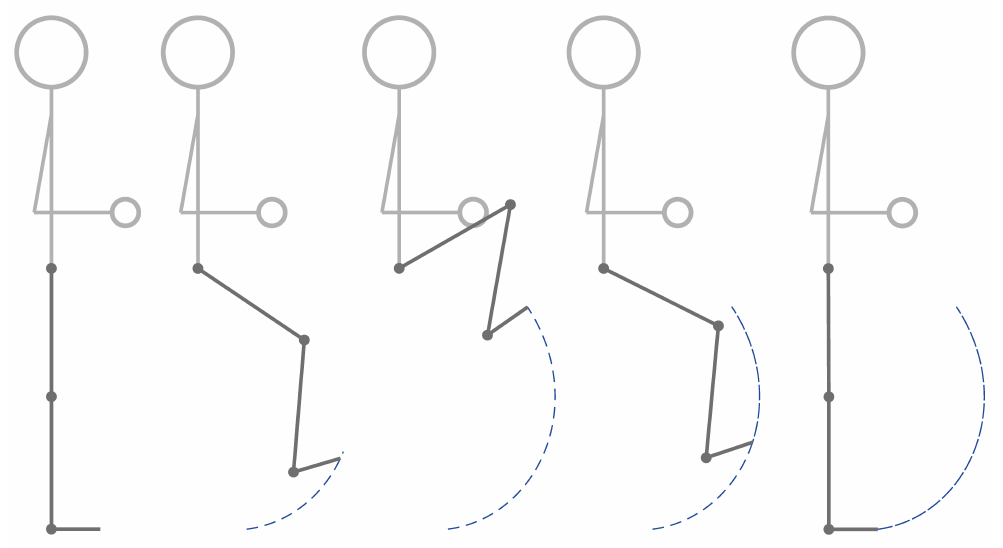
Figure 5. Simulated squat